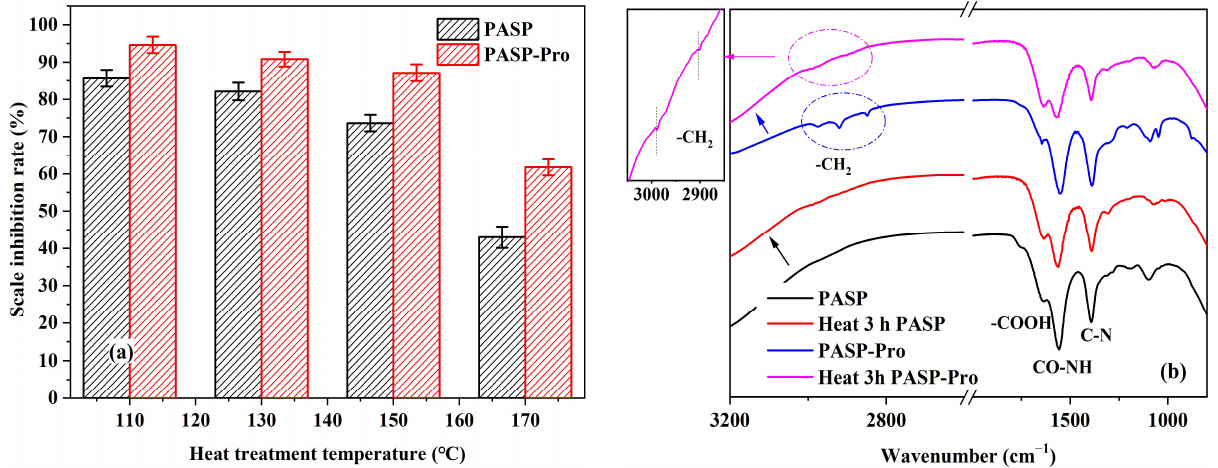
Figure 7. The relationship between scale inhibition rate and heat treatment temperature ( a ); FTIR of scale inhibitors after heat treatment ( b ).